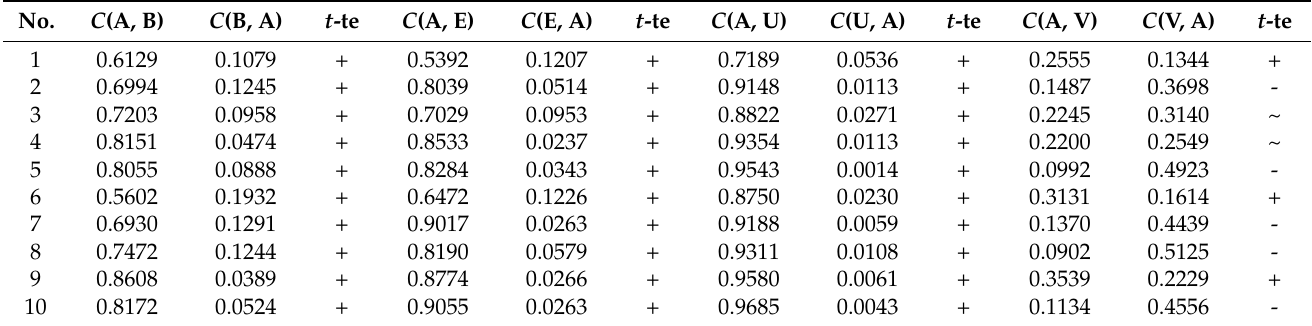
Table 4. Comparison of the experimental results of the five algorithms through the C-metric.